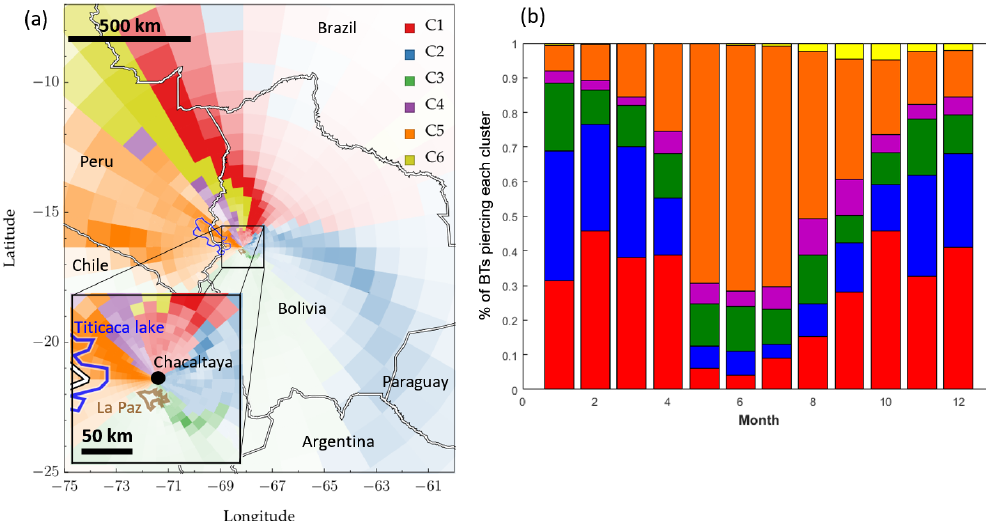
Figure 4. (a) Trajectory frequency plot in the La Paz region in Bolivia, with a scale of 500 and 50km in the lower left corner centred on the CHC station. (b) Monthly variation in the percentage of BTs for each